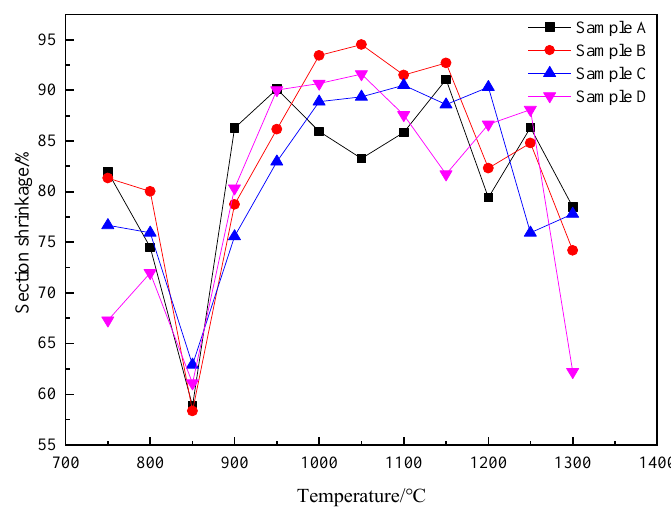
Figure 7. High-temperature thermoplastic curves of high-rise structural steel with different Nb contents.